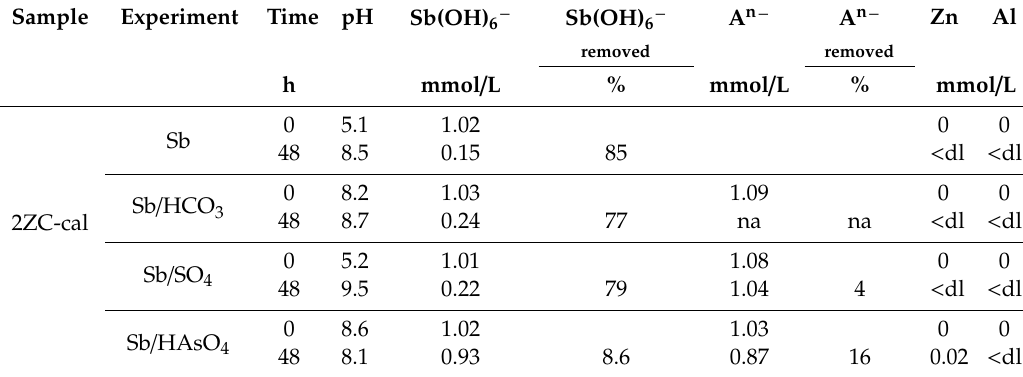
Table 2. Solution pH values and dissolved ions determined before and at the end of the sorption experiments performed with 2ZC-cal without competitors (Sb), and with coexistent HCO 3 − (Sb / HCO 3 ), SO 42 − (Sb / SO 4 ) or HAsO 42 − (Sb / HAsO 4 ). (A n − = HCO 3 − , SO 42 − or HAsO 42 − ; na = not analyzed; dl = detection limit; dl Zn = 0.2 µ mol / L; dl Al = 7 µ mol / L).